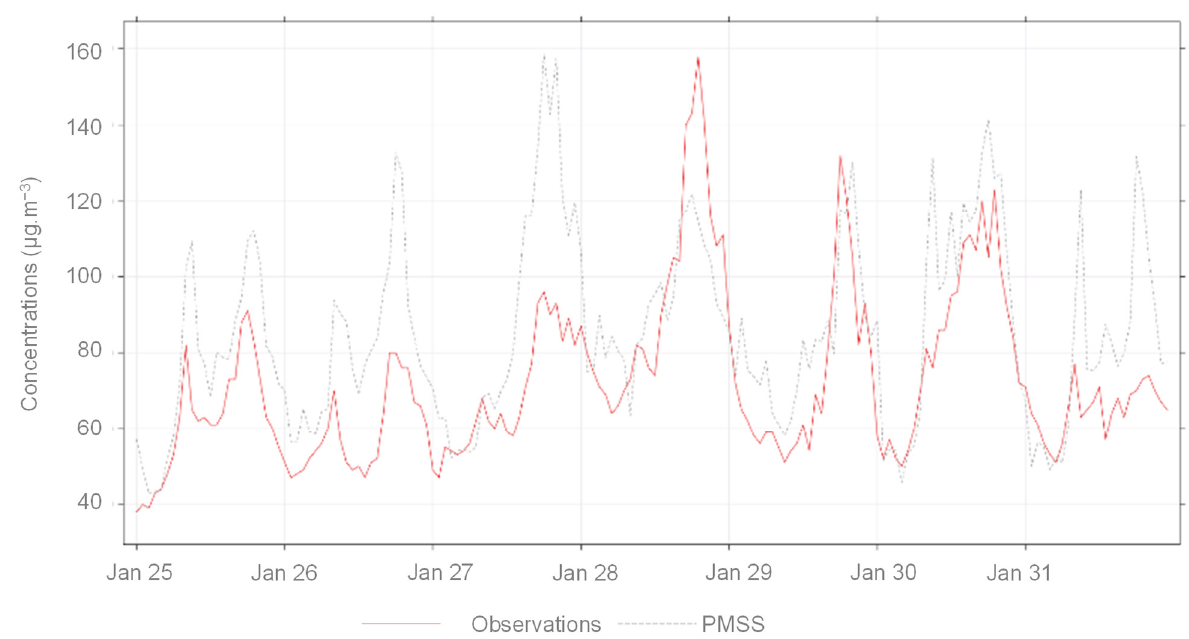
Figure 4. Time series of observed and computed concentration of NO 2 at Grenoble_boulevards station between the 25th of January 2017 and the 31st of January 2017.